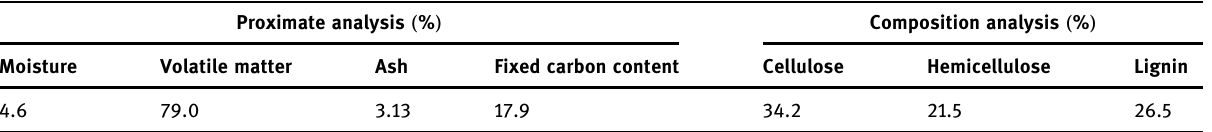
Table 1: Properties of the pruned wolfberry branches Proximate analysis ( %